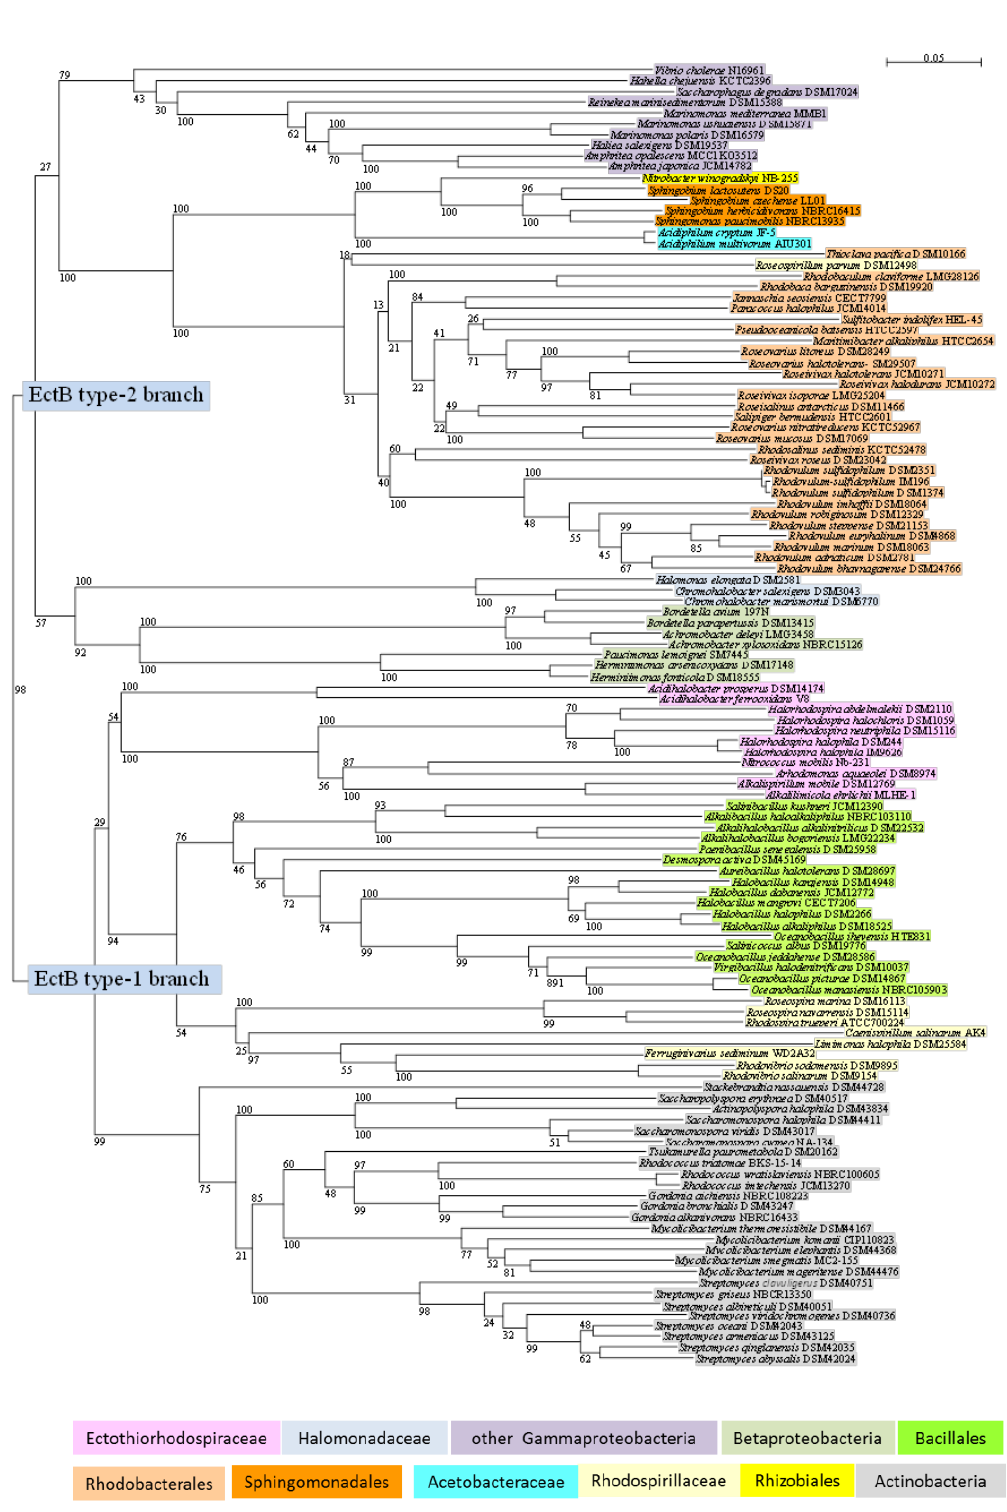
Figure 2. The phylogeny of ectoine biosynthesis on the basis of sequences of diaminobutyrate-pyruvate aminotransferase EctB is shown in a neighbor-joining tree. Sequences and gene bank accession numbers are shown in the Supplementary Table S2. Bootstrap values expressed as percentages of 1000 replications are given at the branches. The bar indicates an evolutionary distance of 0.05. The following color code highlights different systematic groups. As shown in Figure 2, a first major phylogenetic branch (EctB type-1) contains four clearly separated groups: (1) the Ectothiorhodospiraceae, (2) Rhodospirillaceae including the